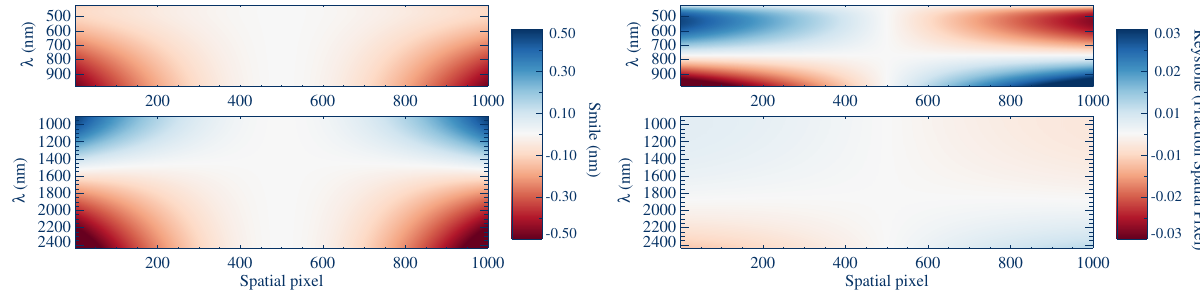
Figure 4. Expected spectral smile ( left ) and keystone ( right ) effects for the two EnMAP spectrometers as a function of spectral and spatial positions in the VNIR and SWIR focal plane arrays ( top and bottom , respectively). The mission requirements of smile and keystone < 20% are largely fulfilled thanks to the curved prism disperser approach adopted for the spectrometers’ optical